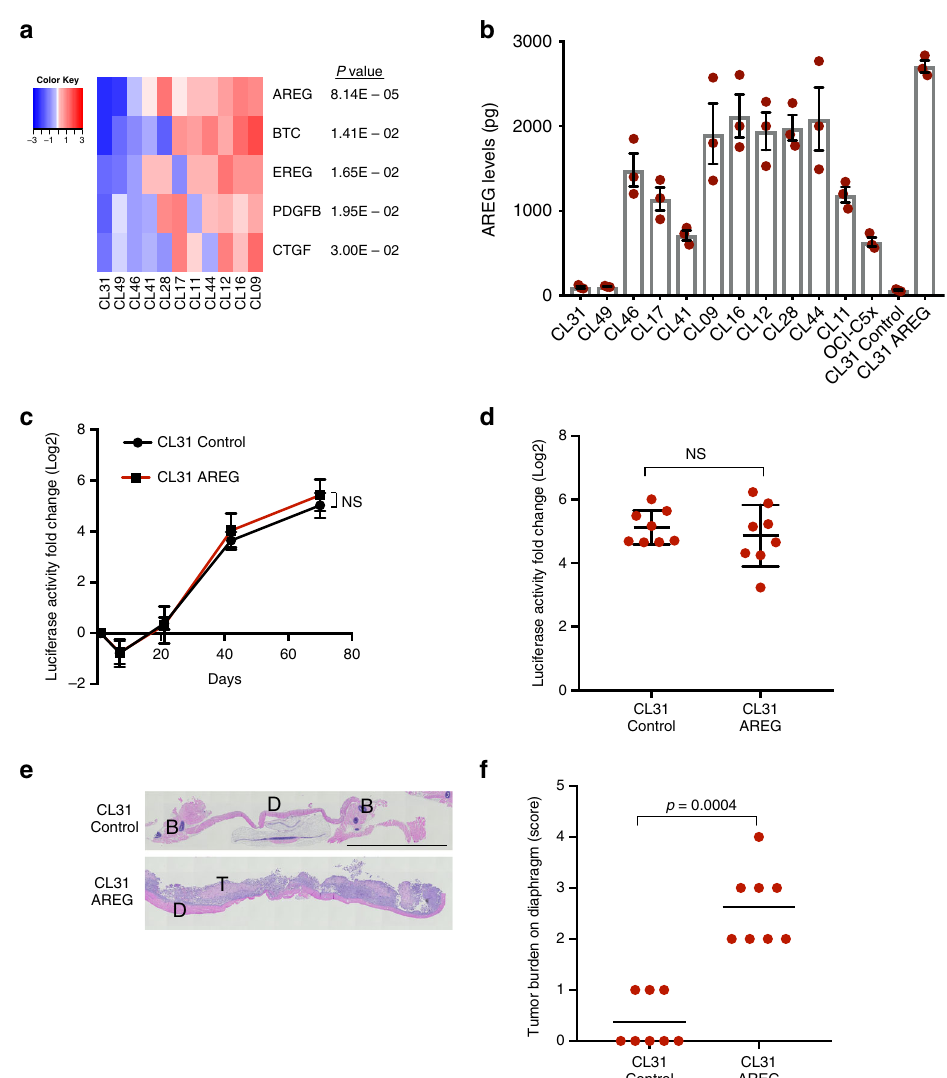
Fig. 4 Overexpression of amphiregulin induces peritoneal metastasis of CL31. a Heatmap of ligands identi fi ed by RNA-sequencing. Growth factors and cytokines that were expressed by one or more of the other clones and poorly expressed in CL31 were identi fi ed and fi ltered for those whose corresponding receptor(s) were expressed in CL31 (cpm > 2). The relative mRNA levels of the identi fi ed ligands/growth factors are shown. Data are mean centered Log2. FDR-corrected p values were calculated using the exact binomial test in edgeR. b Levels of AREG secreted into the media by the indicated clonal populations over the course of 36 h, as determined by an ELISA assay. Data represent as mean ± SEM from three independent experiments. c Tumor burden in vivo assessed by measurement of luciferase activity in whole blood samples collected at the indicated time points. Data presented as fold change in luciferase activity compared to 24 h post injection. Representative of two independent experiments. Data summarized by mean ± SD, p values were computed using the Student ’ s t test and FDR corrected. d Fold change in luciferase activity in blood samples of individual mice collected at the end point (10 weeks) relative to the 24 h time point. The data shown as mean ± SD. p Values were computed using the one-way ANOVA test and Dunnett ’ s multiple comparison test. e Representative H&E images of solid peritoneal metastases on the diaphragm of mice inoculated with CL31 expressing AREG or vector control. T tumor cells, D diaphragm. Scale bar, 2 mm. f Tumor burden score of solid metastases on the diaphragms of mice inoculated with CL31 expressing AREG or vector control, determined as in Fig. 2e. p Value was computed using the chi-square test with Monte Carlo simulation. d – f Data from two independent experiments, total n = 8 the AREG antibody-treated group compared to vehicle control suggesting that CL17 does not co-exist with CL31 in the solid (Fig. 6d – f), suggesting that AREG blocking antibody speci fi cally peritoneal metastases or malignant ascites at the end point interferes with the formation of solid peritoneal metastases. (Supplementary Fig. 9). To test the abundance of CL31 and CL17 in the resultant Together, the results from the above experiments involving tumors of CL31:CL17 mixture, barcode representation analysis multiple approaches to evaluate the role of non-tumorigenic was performed on malignant ascites and solid masses on the clones and AREG in regulating CL31 metastasis provide strong diaphragm at the 10-week time point. The results showed that evidence that transient and non-tumorigenic clones cooperate CL17 barcode reads were below background levels (de fi ned as the with CL31 to affect tumor aggressiveness and that the interclonal barcode reads for CL11, which was not present in the mixture) cooperation is, at least in part, dependent on AREG.